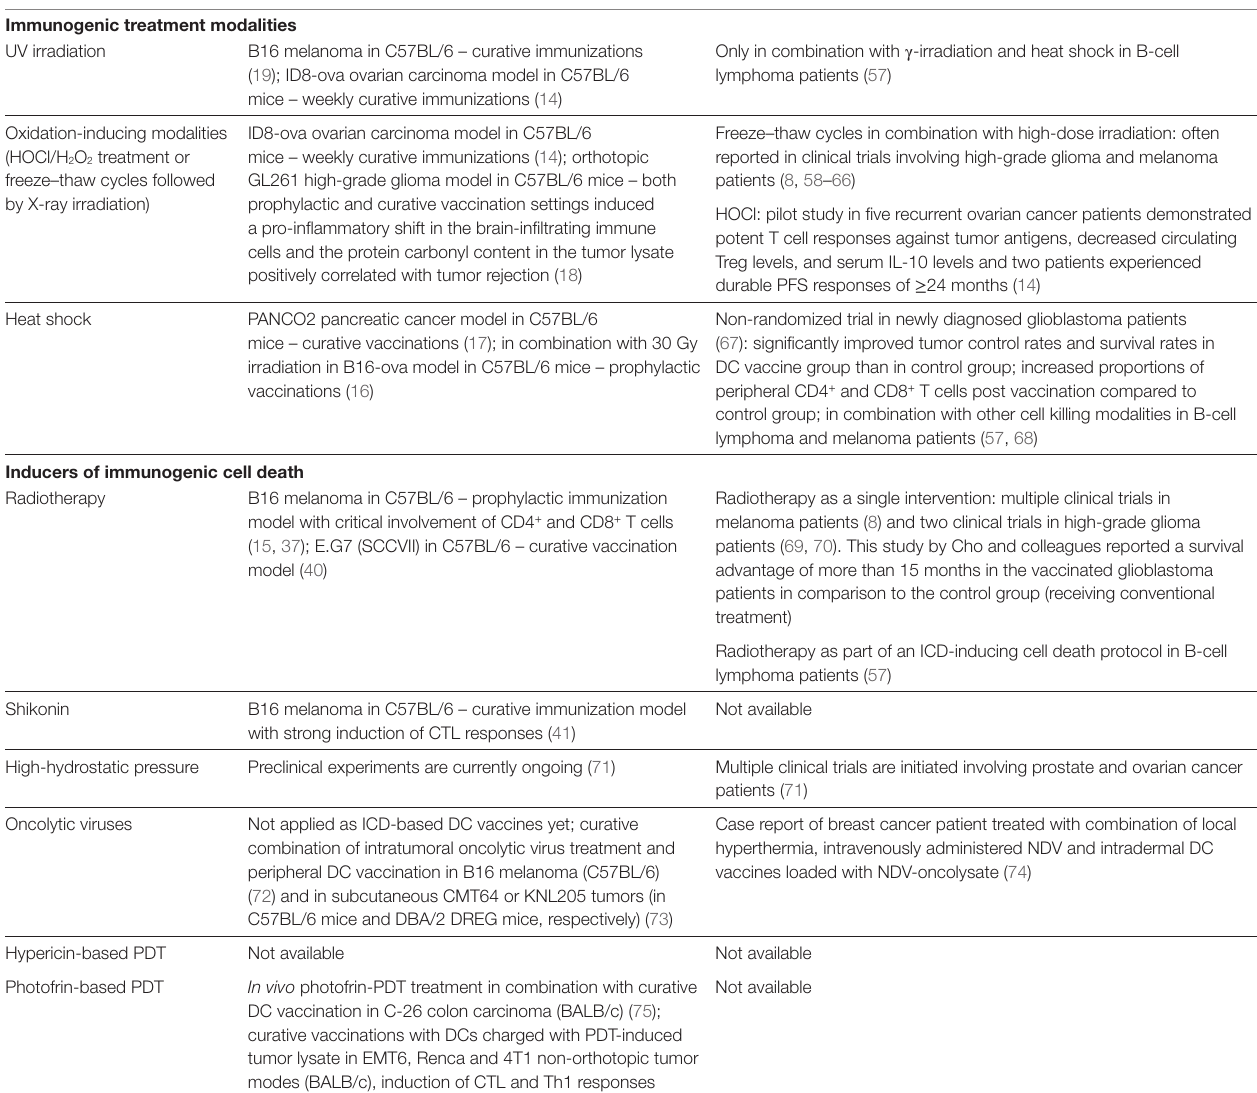
TABLe 2 | A list of preclinical tumor models and clinical studies for evaluation of the in vivo potency of DC vaccines loaded with immunogenically killed tumor cells. Treatment modality Preclinical experience in DC vaccine settings Clinical experience in DC vaccine